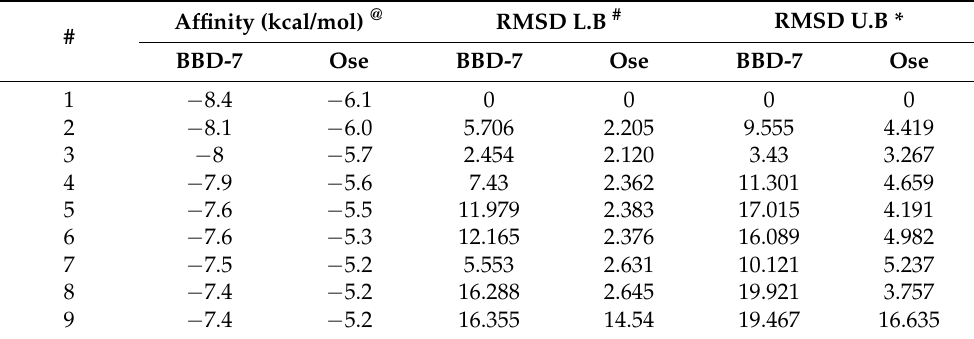
Table 2. Binding energies of the BBD-7 compared with oseltamivir on NA along with their Root Mean Square Distance value.